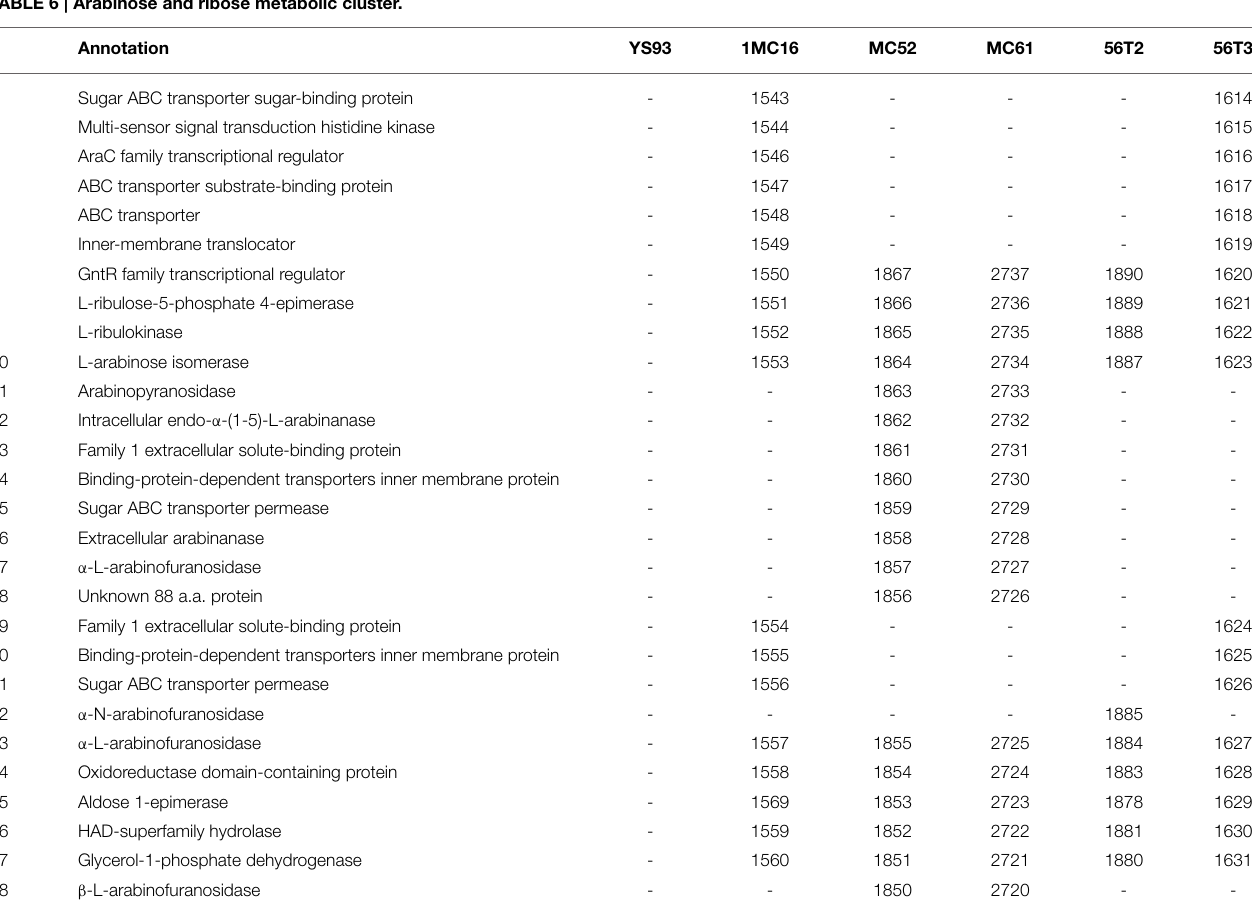
TABLE 6 | Arabinose and ribose metabolic